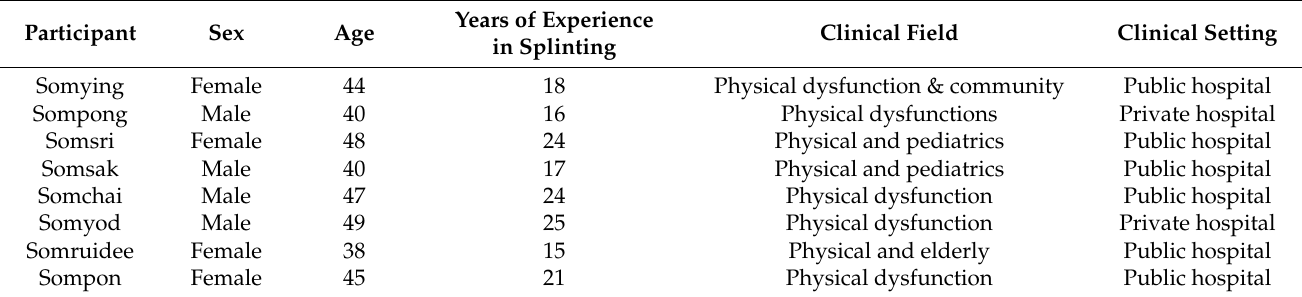
Table 2. Demographic characteristics of participants in the interview ( n =